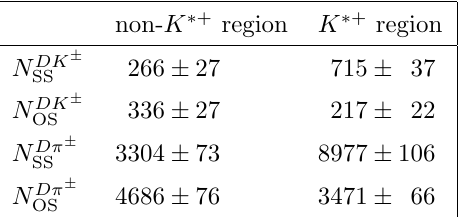
Table 1 . Signal yields summed over charge, as measured in each Dalitz